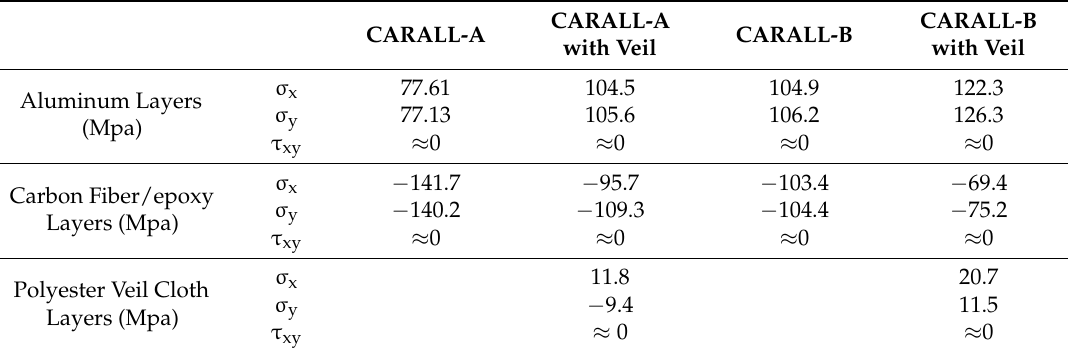
Table 10. Thermal residual stress predictions in tensile samples.